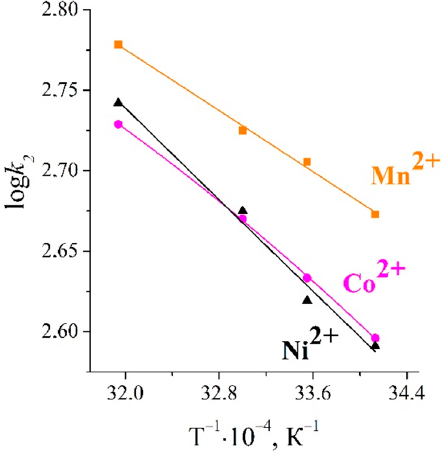
Figure 9. Plot of log k 2 vs. 1/ T for pseudo-second-order kinetics model. The values of activation energy, adsorption rate constants, and ionic potentials were found to change in following order: Mn(II) > Co(II) > Ni(II). The same decreasing order of sorption rate constants k 2 were also found to be maintained in a study of the sorption kinetics of Mn(II), Co(II), Ni(II) Cu(II), and Cr(II) ions in a multicomponent solution. The interpretation of the experimental data for Mn(II), Co(II), Ni(II), and Cu(II) given by the Elovich model (Figure 10, Table 3) shows that plots of q t versus log t gave linear relationships with R 2 > 0.99 in the chosen temperature range.